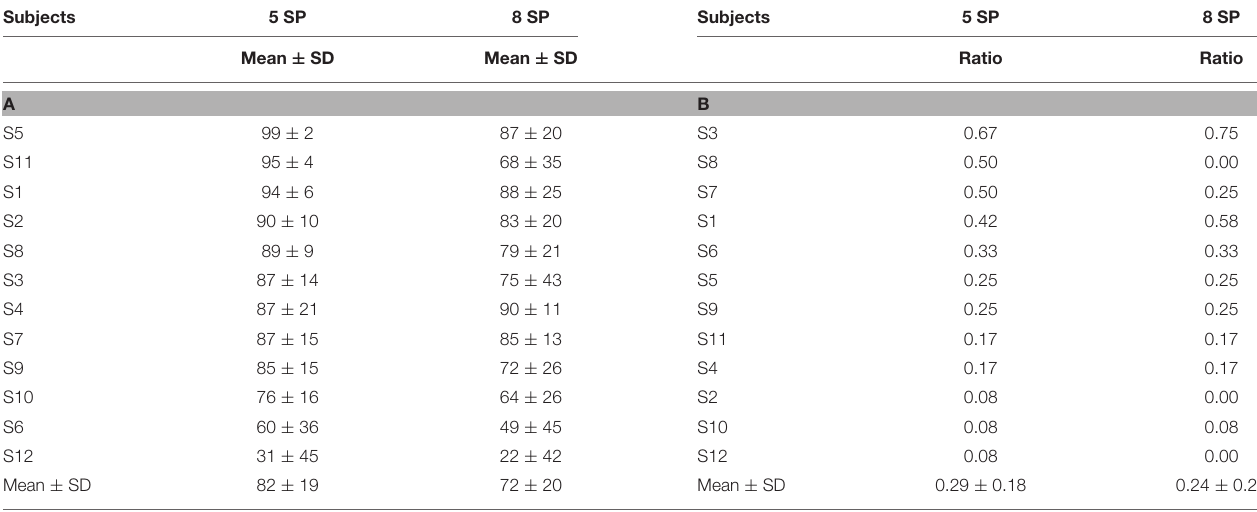
TABLE 2 | (A) In the training session, mean ( ± SD) classifier accuracy (%) for the 5 and 8 static postures (SP) conditions. Subjects 5 SP 8 SP Subjects 5 SP